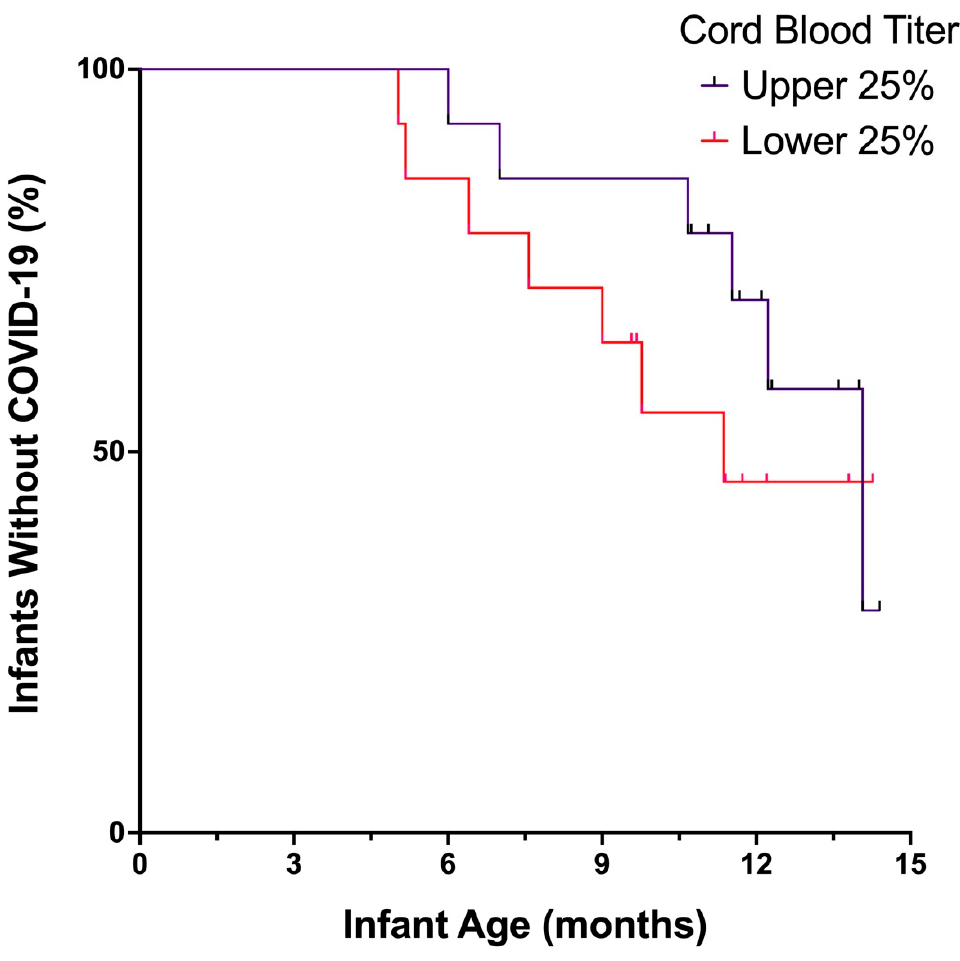
Figure A2. Relationship between cord blood antibody titers and SARS-CoV-2 infection in whole infant cohort. Kaplan–Meier curve displays time to SARS-CoV-2 infection of all infants in the cohort with cord antibody titers in the upper and lower quartiles, including those who developed COVID-19 and those who remained infection-free. Cord blood anti-Spike IgG titers in the top quartile suggested longer COVID-19 disease-free interval, although this finding did not achieve statistical significance over the 15-month follow up period (Mantel-Cox p = 0.333).